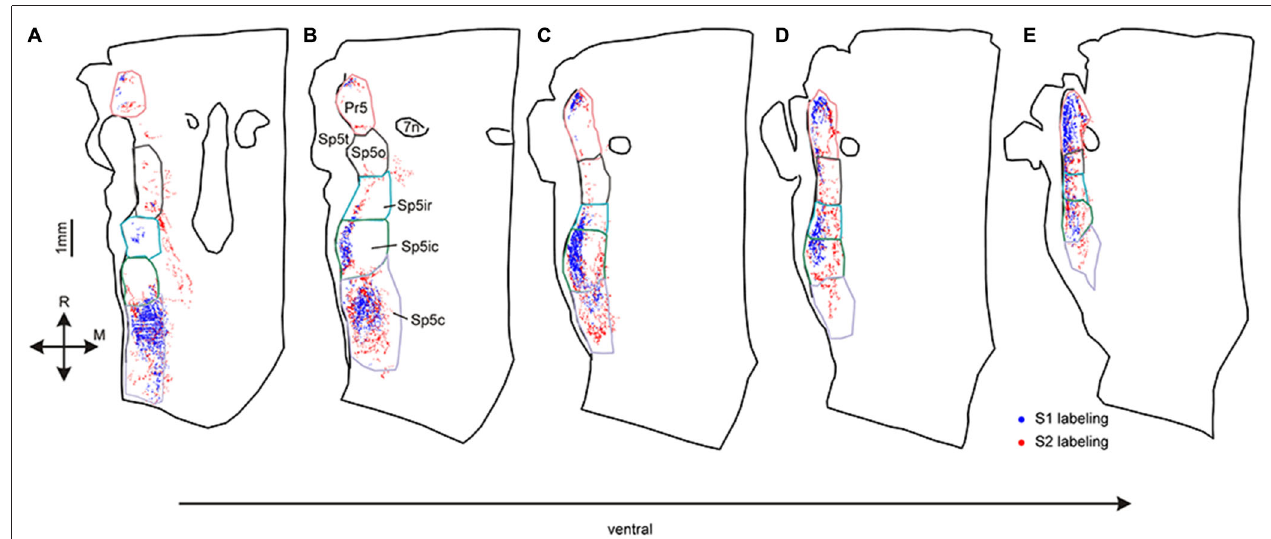
FIGURE 2 | Digital reconstructions of anterogradely-labeled terminals in five horizontal sections spanning the entire dorsoventral extent of the trigeminal sensory nuclei. Labeled S1 corticofugal terminals are shown in blue, S2 terminals in red. Sections are arranged from the most dorsal (A) to the most ventral (E) . Outlines of the different trigeminal sensory nuclei, defined using adjacent CO sections are shown superimposed on the plotted terminals. Consecutive sections were 180 µ m apart.